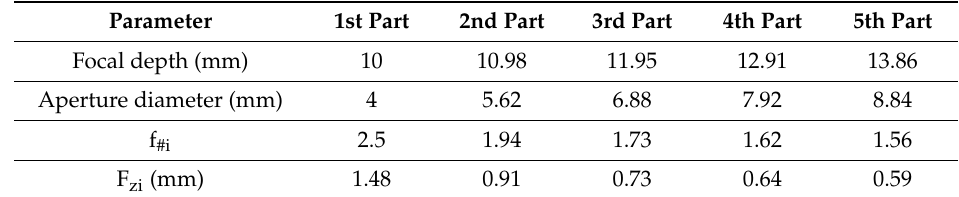
Table 2. The estimated parameters of the MFP transducer using five focal points (distance between two focal points is b = 1 mm; center frequency of each part is f c = 50 MHz).